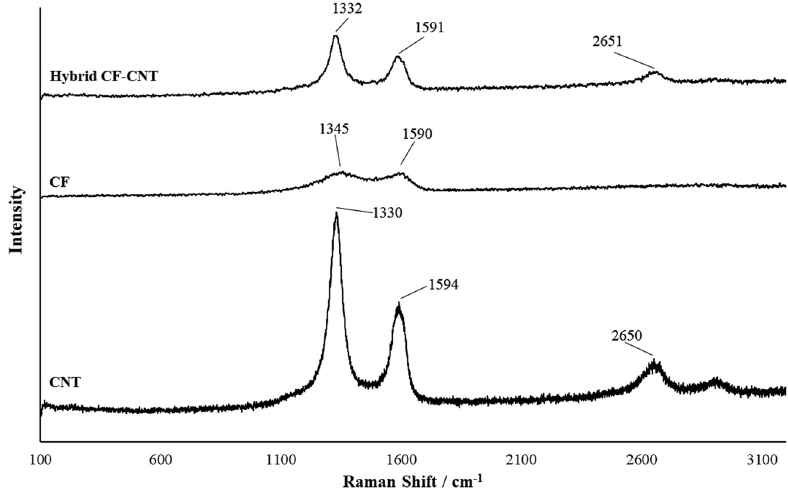
Figure 5: Raman spectra of CNT, CF and hybrid CF – CNT.